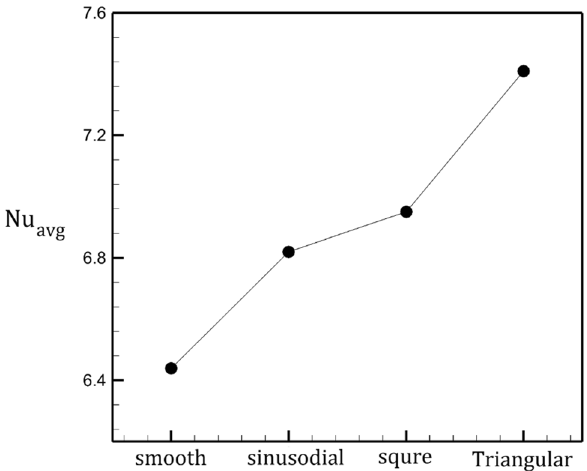
Figure 14. Evaluation of average Nusselt number for different types of tube